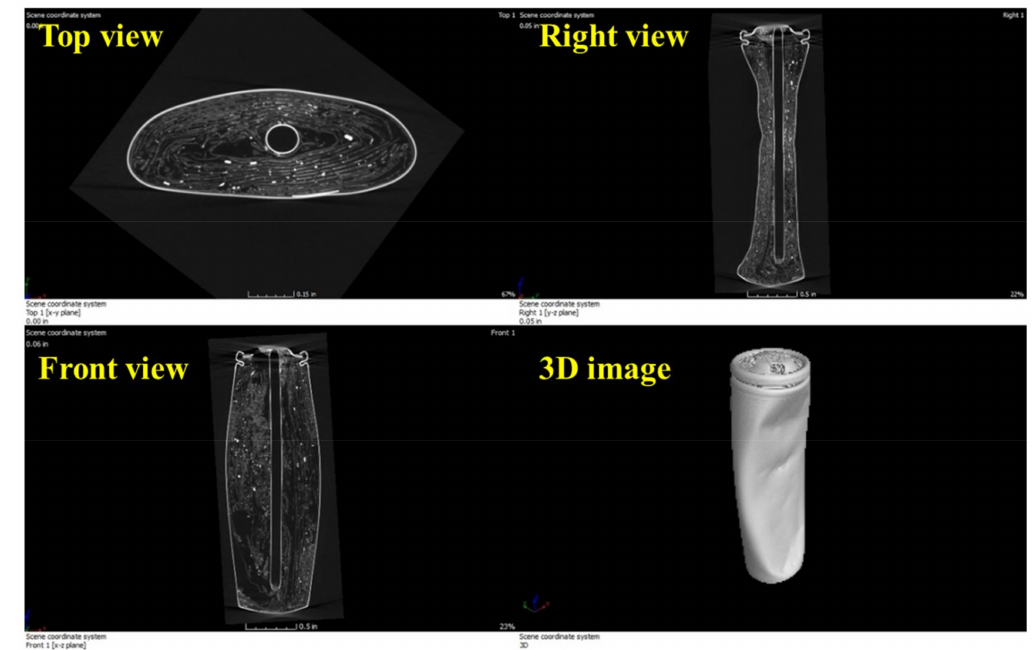
Figure 10. CT scan of the sample A1.